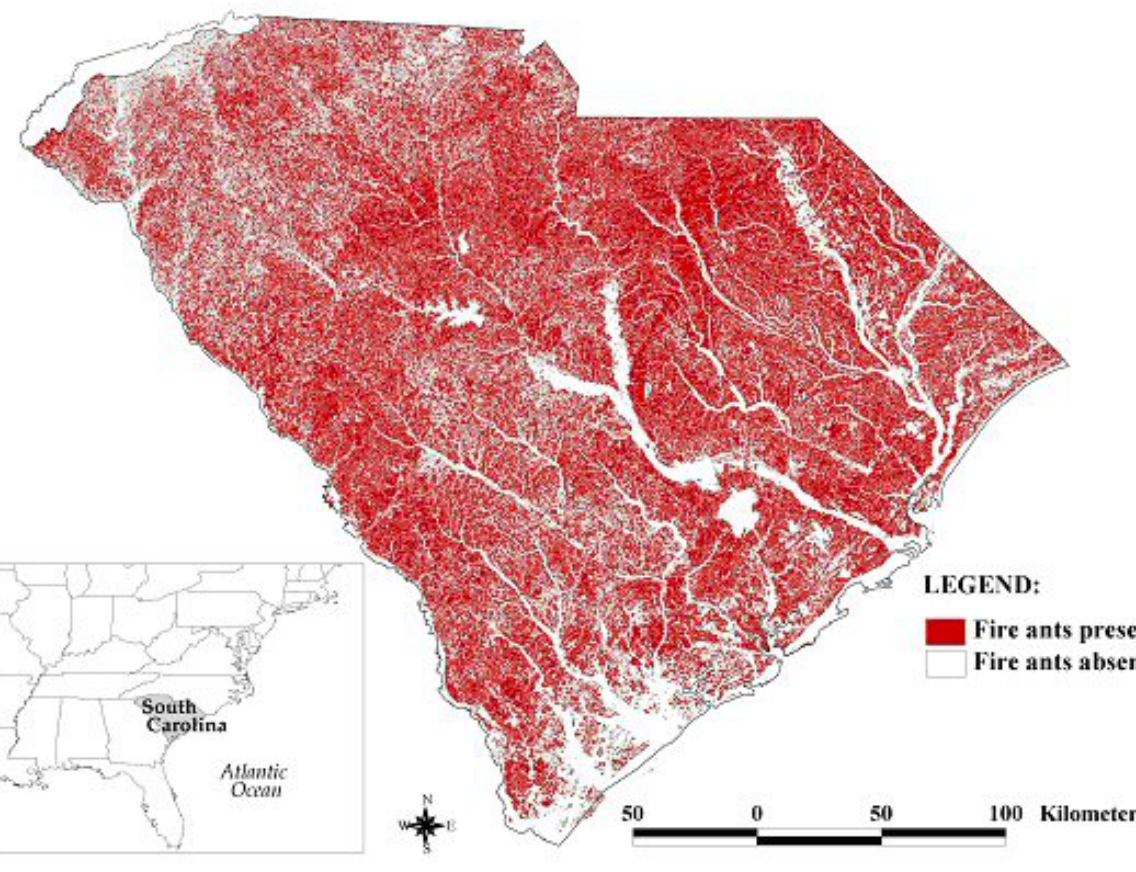
Fig. 1. Predicted fire ant distribution map (90% probability) for the state of South Carolina, USA, based on stepwise logistic regression analysis of sampling data, 1999-2000. We modeled the presence/absence of the stressor, i.e., fire ants, as the dependent variable, and habitat, soils, aspect, and landscape metrics such as patch size, shape, the euclidean distance of the survey location to a development, the area of development at various buffer distances around each survey location, the euclidean distance of the survey location to a paved road, were independent predictor variables. Only habitat variables were significant predictors of fire ant